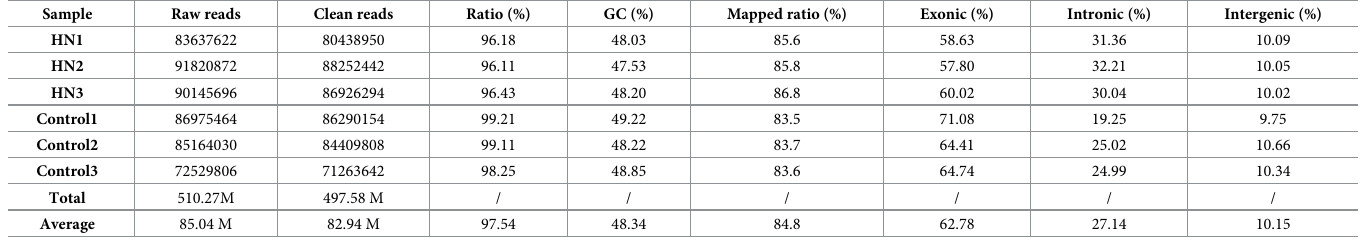
Table 1. Summary of RNA-seq